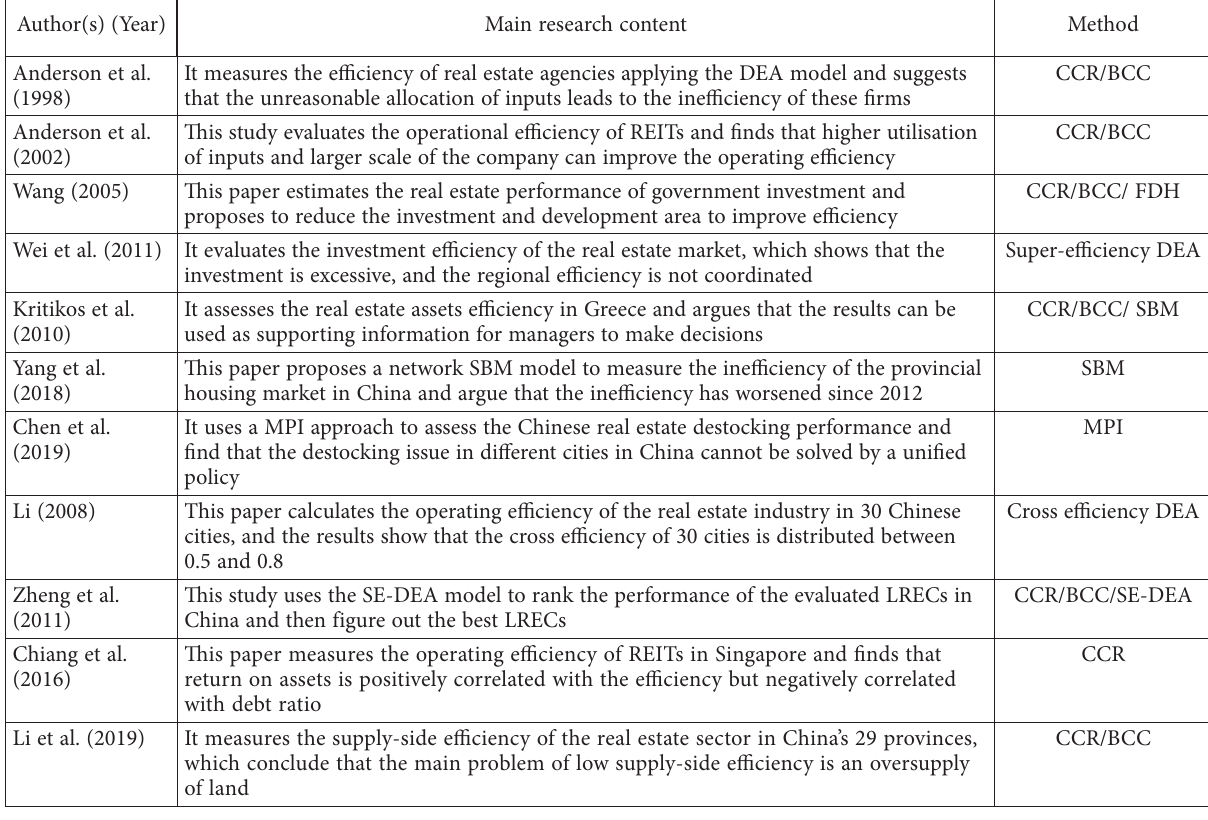
Table A1. Previous literature of the real estate performance research based on the DEA model